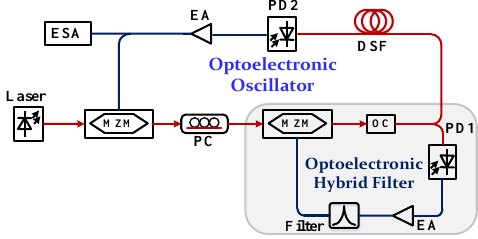
Figure 10. The schematic diagram of the OEO employing a Fabry–Perot etalon and Pound–Drever–Hall frequency stabilization. PC: polarization controller. IM: intensity modulator. VOD: variable optical delay. EDFA: erbium-doped fiber amplifier. AOM: acousto-optic modulator. PM: phase modulator. CIR: circulator. FPE: Fabry–Perot etalon. PD: photodetector. LPF: low-pass filter. PID: proportional–integral–derivative controller. VCO: voltage-controlled oscillator. Reprinted with permission from Ref. [43], IEEE, 2018.